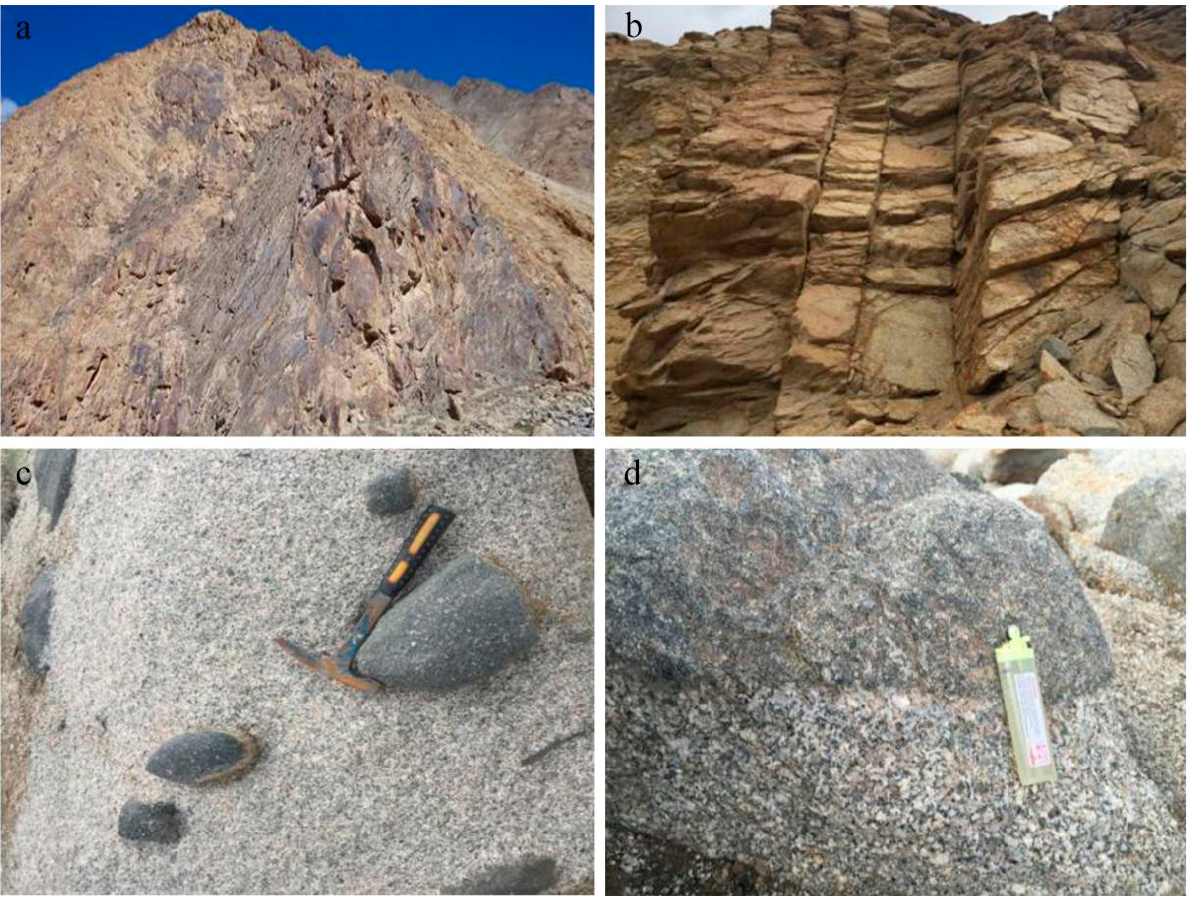
Figure 2. ( a ) Rock surrounding a xenolith in muscovite monzogranite. ( b ) Joints developed inmica monzogranite. ( c ) Dark inclusions developed in biotite granodiorite. ( d ) Tonalite in pulsating contact with biotite quartz diorite.